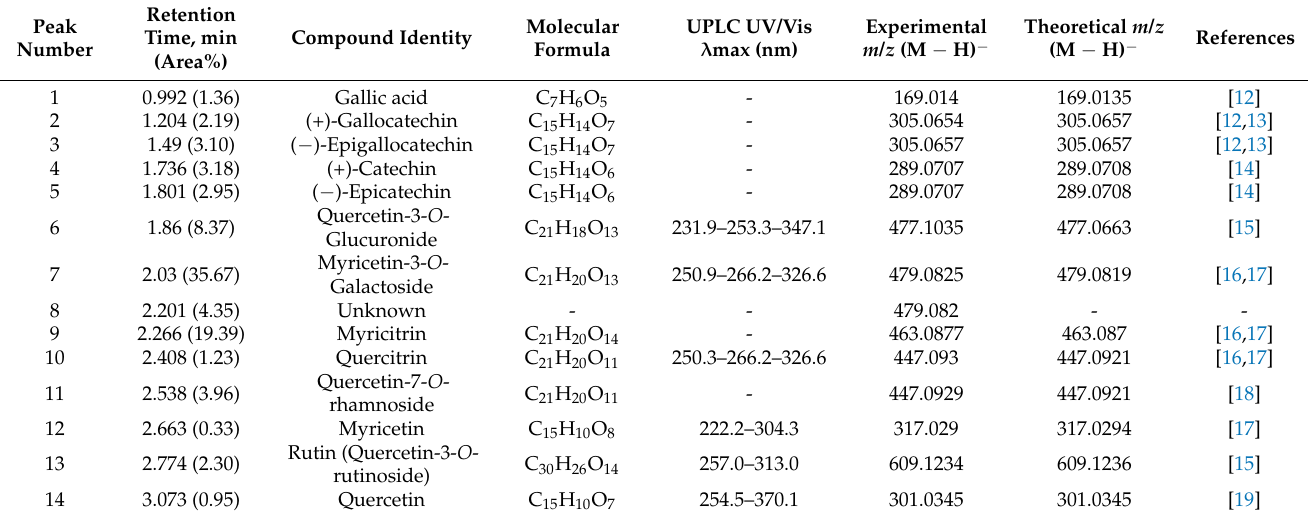
Table 2. Characterization of argan leaves phenolic compounds by